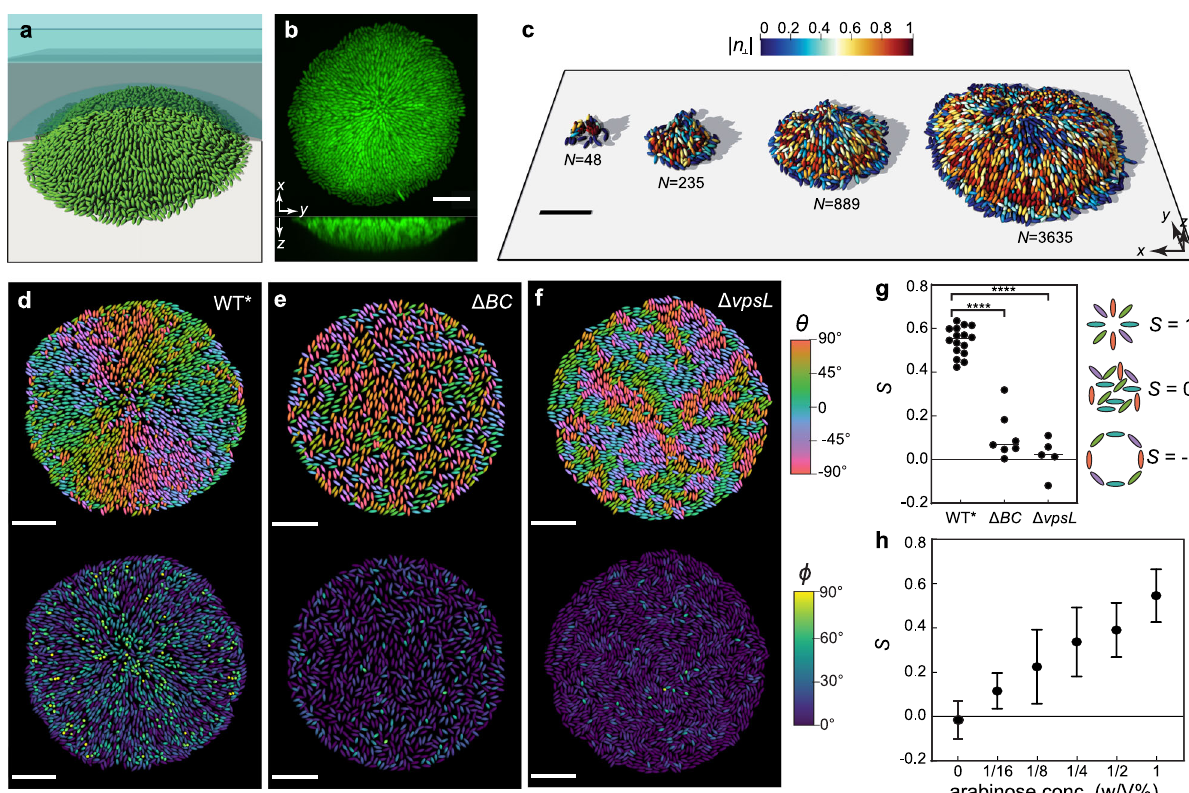
Fig. 1 V. cholerae bio fi lms self-organize into aster patterns. a Schematic of the experimental setup, where V. cholerae bio fi lms (green) were grown on a glass surface covered by a hydrogel (blue shaded). b Representative cross-sectional views of a WT* bio fi lm expressing mNeonGreen. c Single-cell 3D reconstruction of bio fi lm structures over time with different numbers of cells N . d – f Cell orientation color-coded according to each cell ’ s angle in the basal plane θ (top) or the angle it makes with the substrate ϕ (bottom), in a bio fi lm that produces both exopolysaccharides and surface adhesion proteins (WT*; d ), in a bio fi lm that only produces exopolysaccharides ( Δ BC ; e ), and in a bacterial colony with neither exopolysaccharides nor surface adhesion proteins ( Δ vpsL ; f ). Scale bars, 10 µ m. g Radial order parameter S quantifying the degree to which cells conform to an aster pattern in the three strains (lines correspond to median values). Data were subjected to ANOVA with Bonferroni correction for comparison of means (**** denotes P < 0.0001; P ¼ 2 ´ 10 (cid:3) 11 for WT* vs. Δ BC , P ¼ 6 ´ 10 (cid:3) 12 for WT* vs. Δ vpsL and P ¼ 0 : 19 for Δ BC vs. Δ vpsL ). h S in bio fi lms in which the expression of rbmC is controlled by an arabinose inducible promotor (mean ± s.d.; n (cid:5) 4 independent bio fi lms for each condition). Source data are provided as a Source Data fi